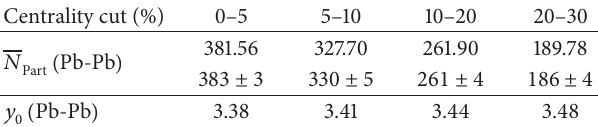
Table 2: The mean numbers of total participants 𝑁 and the Part central positions 𝑦 0 of Gaussian rapidity distribution in different = 2.76 TeV. The numbers with centrality Pb-Pb collisions at √𝑠 NN and without errors are, respectively, the results given by ALICE Collaboration at CERN-LHC [28] and (39).